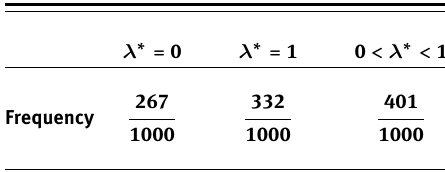
Table 1. Frequency of occurrences of three kinds of λ ∗ in 1000